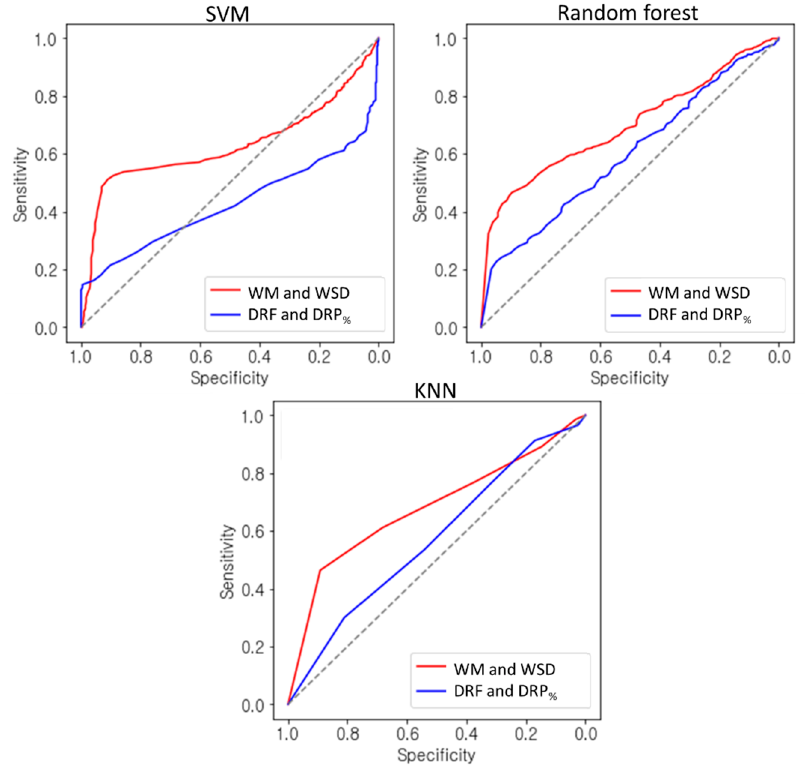
Figure 7. Receiver operating characteristics (ROC) graphs of different prediction models using two different feature sets given in Figure 6. Here the sensitivity corresponds to the ability of predicting the actual ‘drowsy’ epoch as ‘drowsy’. The specificity corresponds to the ability of predicting the actual ‘wake’ epoch as ‘wake’.